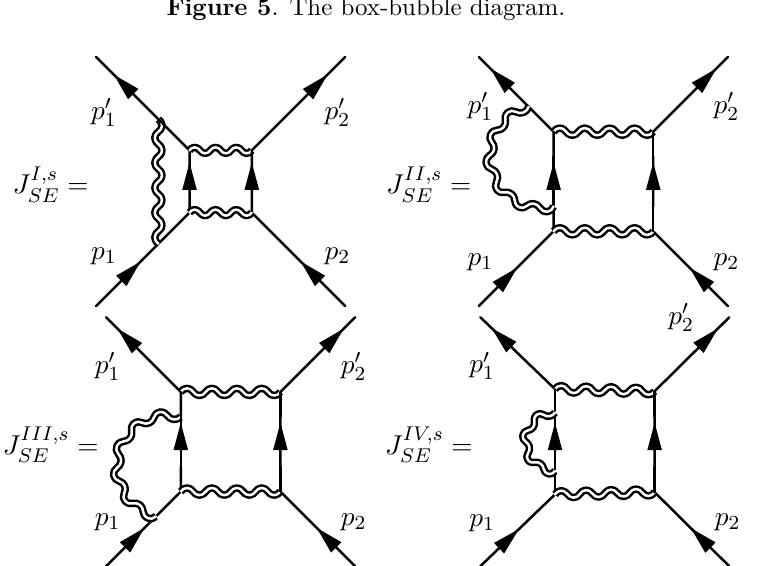
Figure 6 . Self-energy diagrams s -channel with the graviton line attached the one scalar